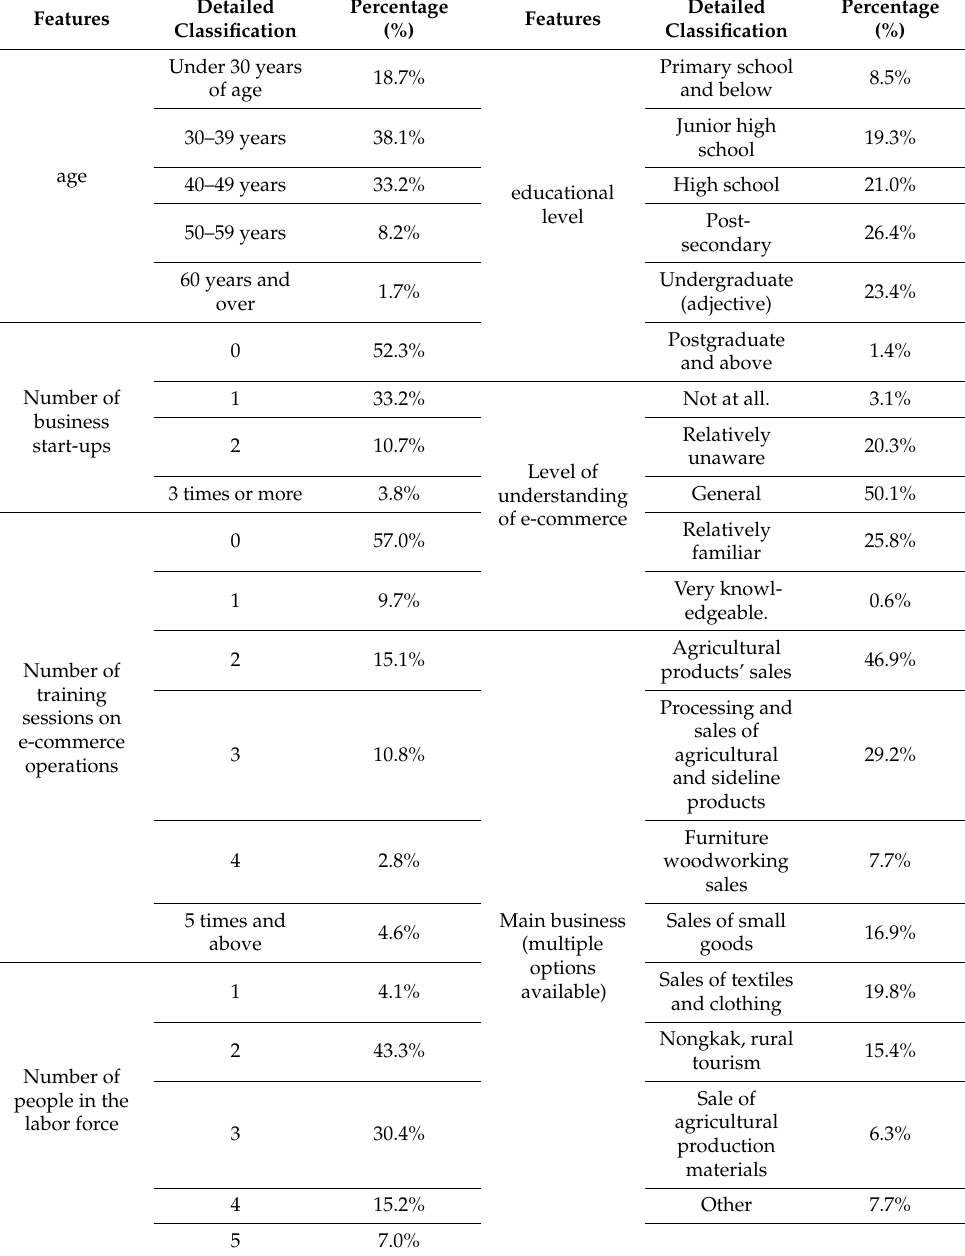
Table 1. Overview of the rural e-commerce